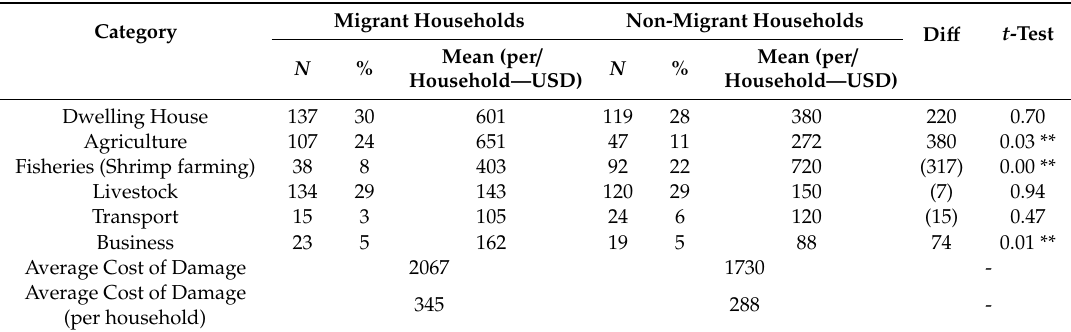
Table 3. Financial loss of assets incurred by Aila among migrant and non-migrant